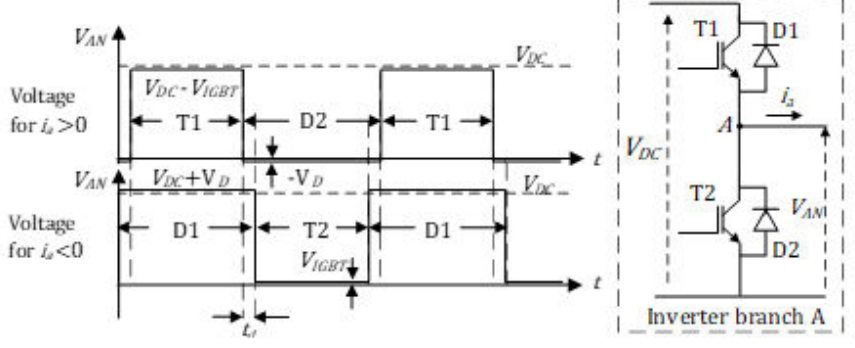
Figure 7. Estimation of one inverter phase branch